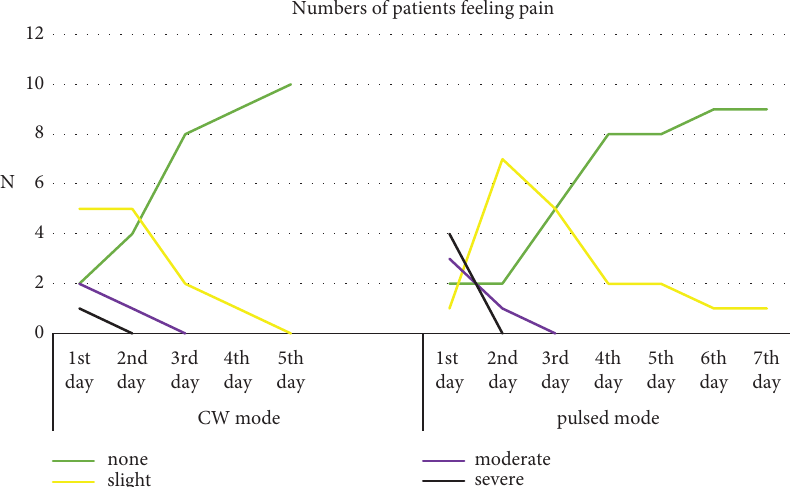
Figure 1: Reveals a decreased number of patients feeling pain during the frst week of treatment with either CW or pulsed diode laser modes.